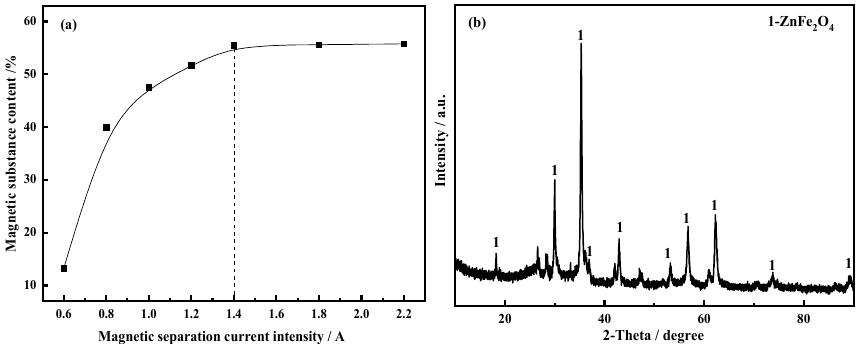
Figure 13. The percentage of magnetic substance and XRD pattern; ( a ) Proportion of substance; ( b ) XRD pattern. Table 7. The element content in magnetic substance.